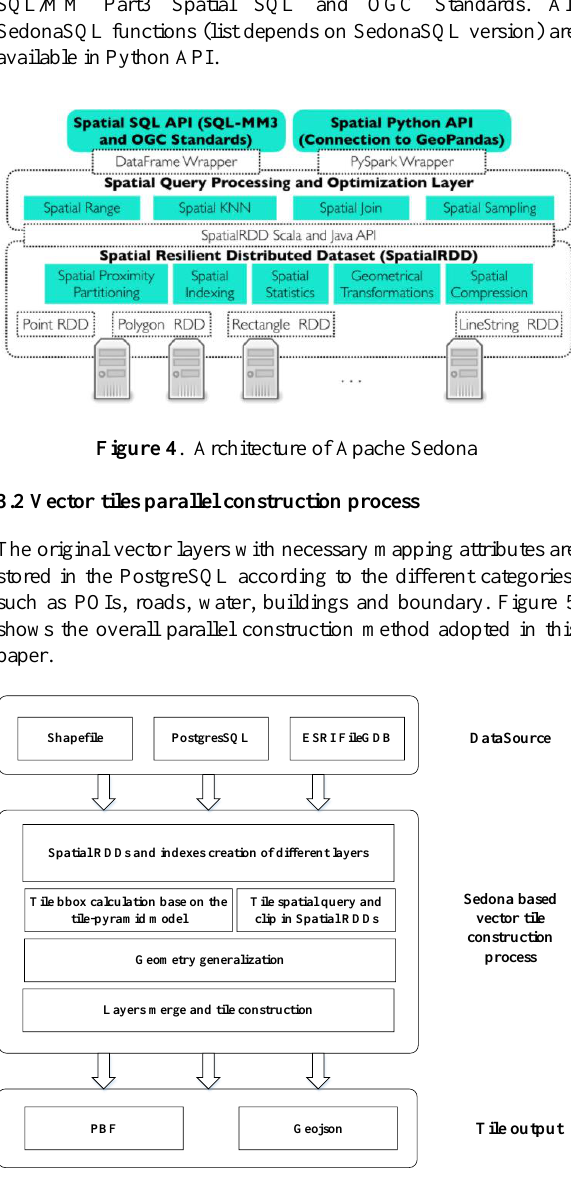
Figure 5. Sedona based vector tile construction process